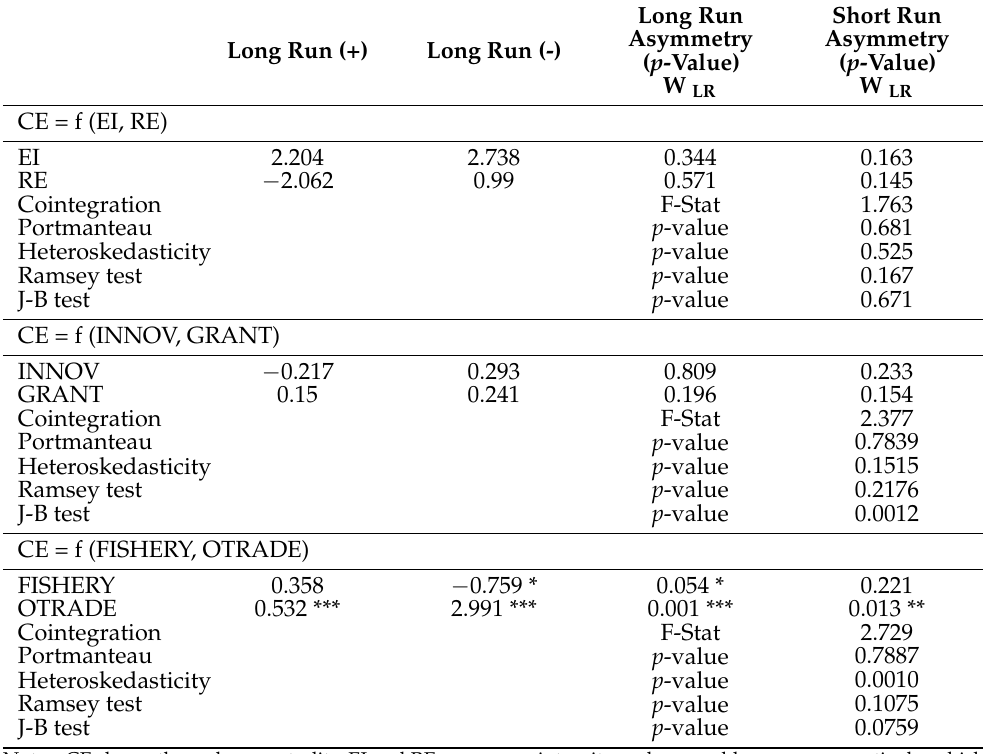
Table 8. Asymmetric and model